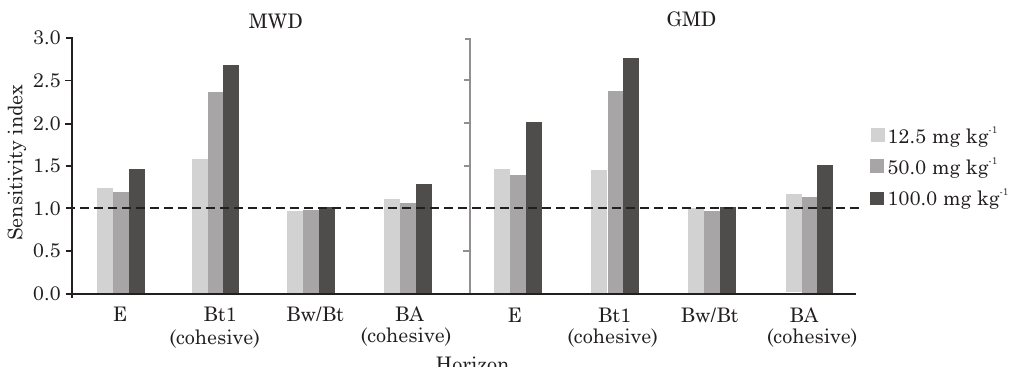
Figure 1. Sensitivity index for mean weight diameter (MWD) and geometric mean diameter (GMD) of aggregates of the horizons E, Bt1, Bw/Bt (Ultisol) and BA (Oxisol) with the application of aqueous solutions of PAM (12.5; 50.0 and 100.0 mg kg -1